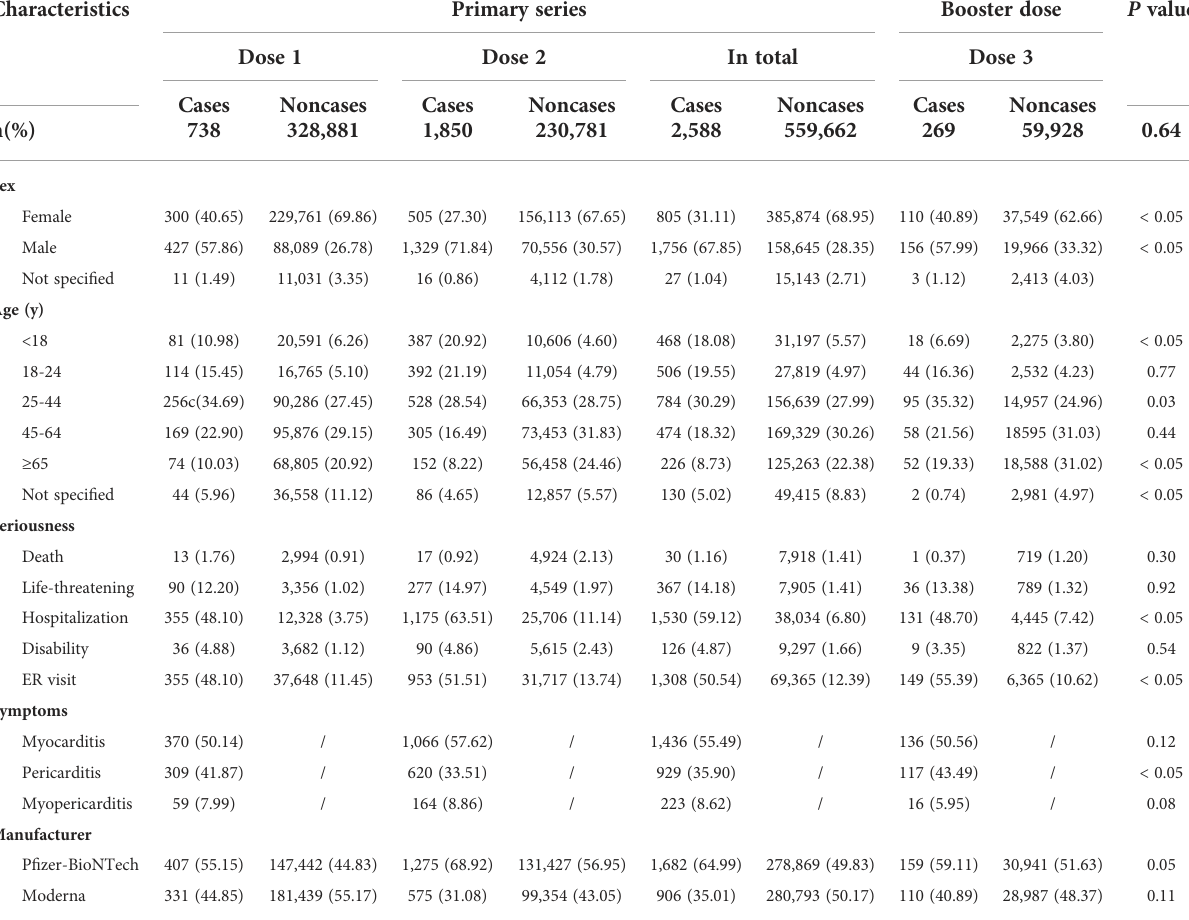
TABLE 3 Characteristics of reports to the VAERS following mRNA COVID-19 vaccination. .